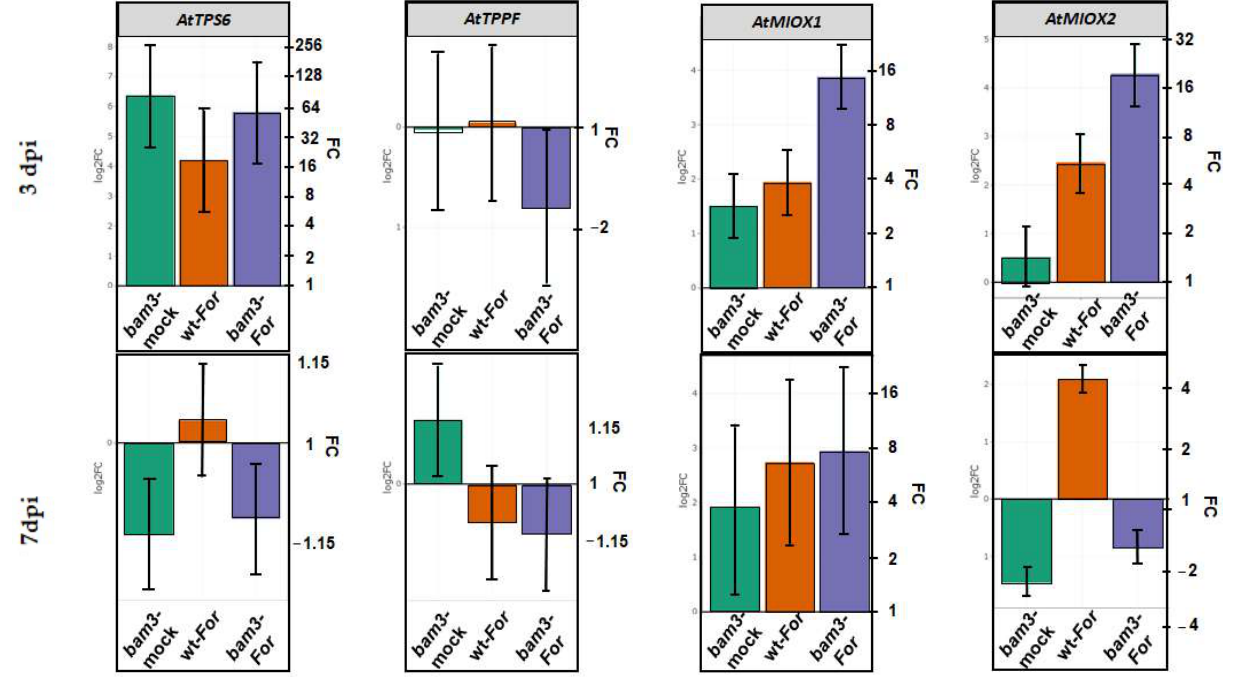
Figure 8. Comparative transcriptional analysis of TPS6 and TPPF , related to trehalose metabolism, and MIOX1 and MIOX2 , related to myo-inositol metabolism. Fold change represents the relative difference in expression between each treatment (i.e., mock bam3 plants, For -inoculated wt plants, and For -inoculated bam3 plants) and control (i.e., wt mock plants) (x axis) at three and seven dpi. Three independent biological replicates, with two technical replicates, were analyzed, and β -ACTIN2 , β -ACTIN7 , and β -ACTIN8 were used as reference genes. Bars indicate the 95% confidence interval of the estimates (2*SE) in all panels. Statistical analysis was performed with linear mixed models. Estimates for which the confidence interval includes the baseline value 0 (1 in fold-change scale) are not significantly different from control at α = 5%.